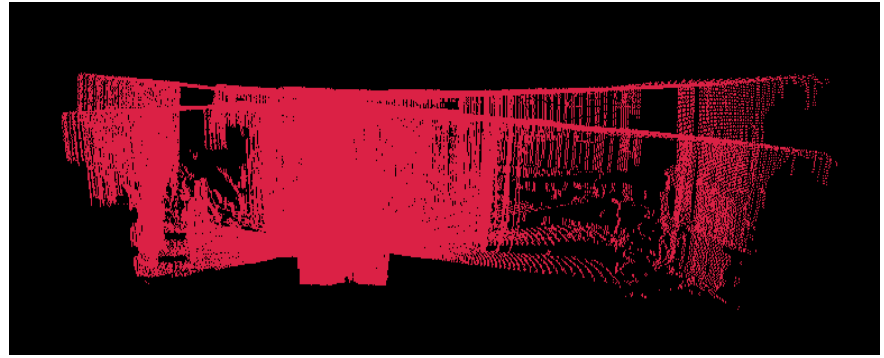
Figure 5. Original scan captured by our R2D-LIDAR system without calibration.